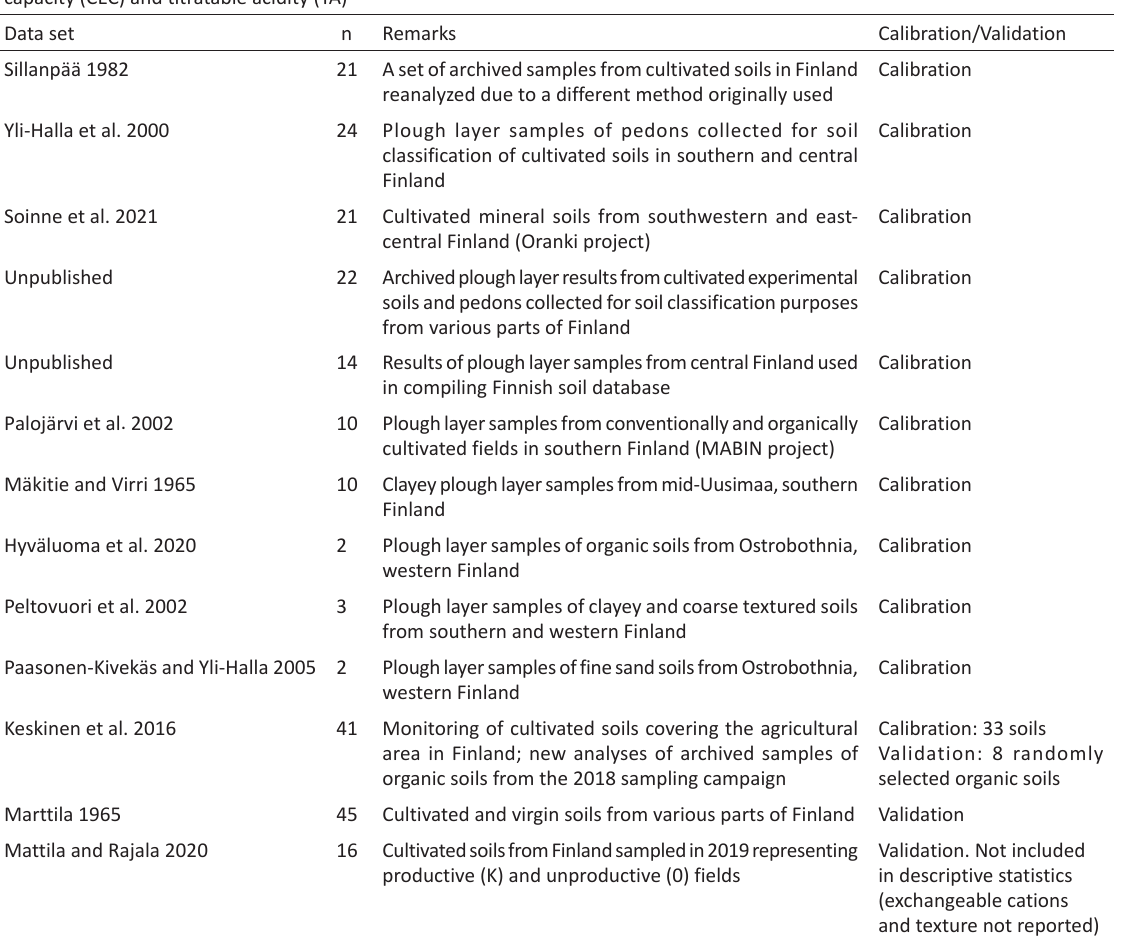
Table 1. Data sets with number of soil samples (n) used in this study for the modelling (calibration/validation) of cation exchange capacity (CEC) and titratable acidity (TA) Data set